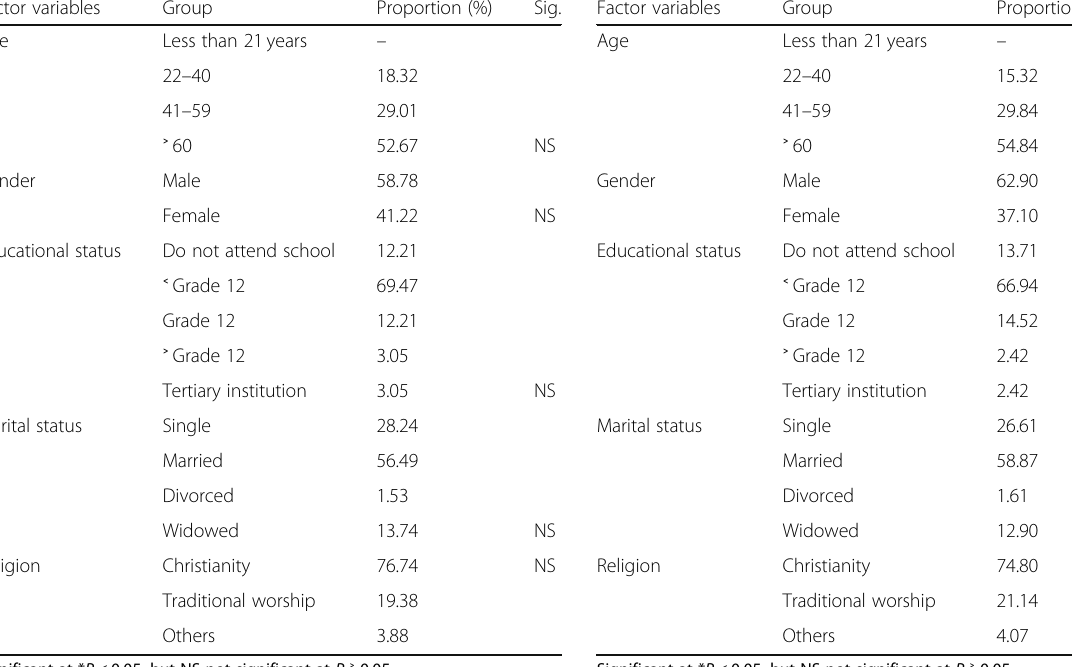
Table 4 Chi-square test result of factors that influence small-scale